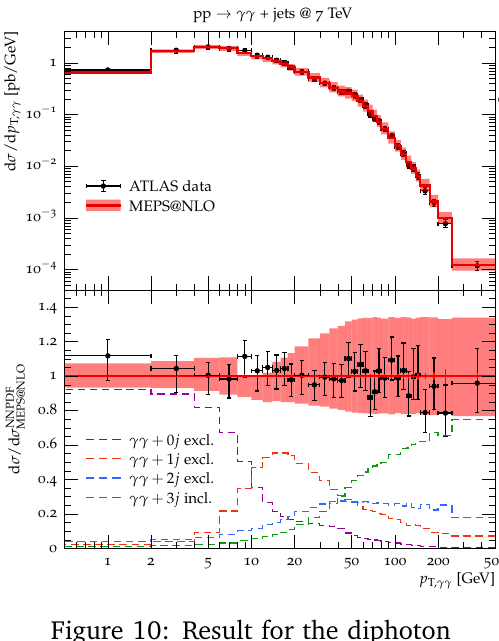
Figure 10: Result for the diphoton transverse-momentum distribution at the L HC , in comparison to data taken from [ 188 ]